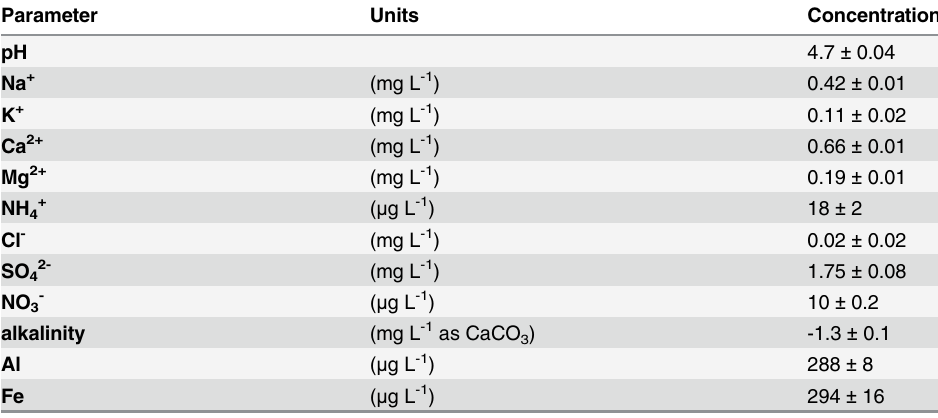
Table 1. Initial composition of filtered